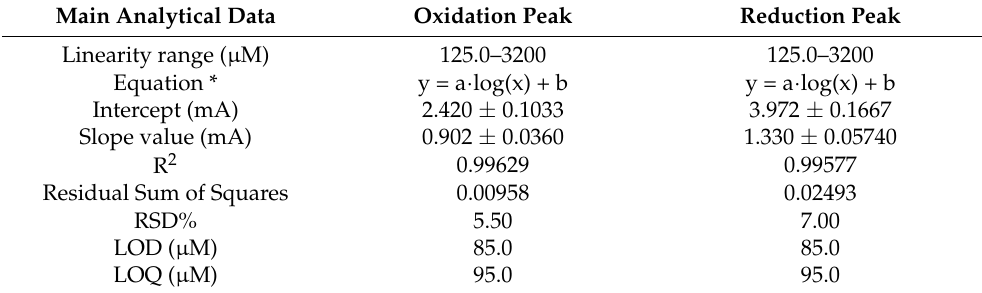
Table 1. Analytical method validation: main analytical data of the straight-line curves reported in Figure 6c,f, using oxidation peak and reduction peak, respectively.